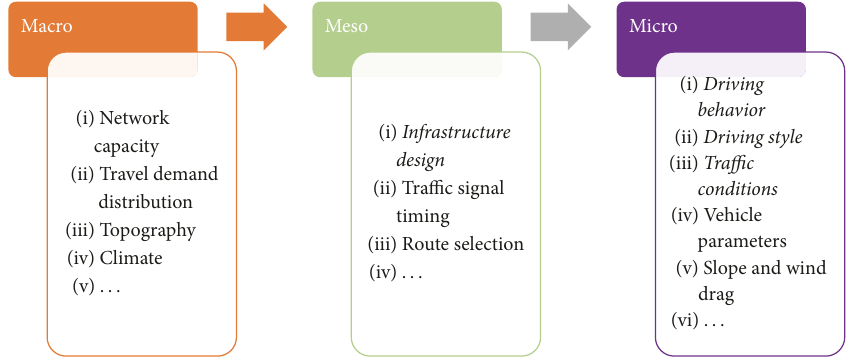
Figure 1: A hierarchical map of influencing factors for EV energy consumption (factors considered in the empirical study printed in